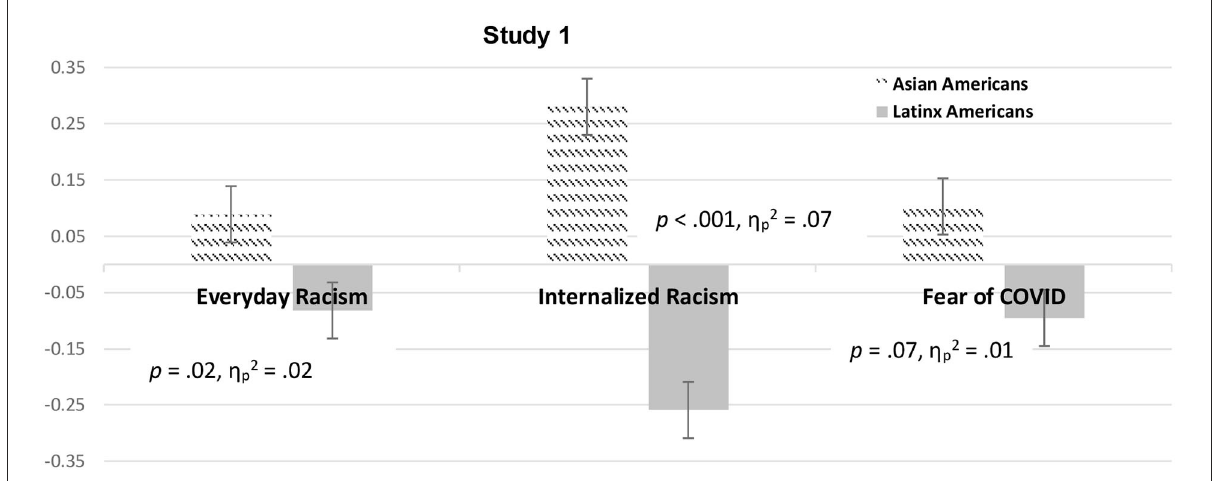
FIGURE1 Psychosocial factor scores for Asian and Latinx Americans across study 1 controlling for covariates. Note . Psychosocial factor scores of Asian and Latinx Americans are shown for everyday racism, internalized racism, and fear of coronavirus (error bars show standard errors) controlling for everyday racism before the pandemic, gender, generation status, and socioeconomic status.